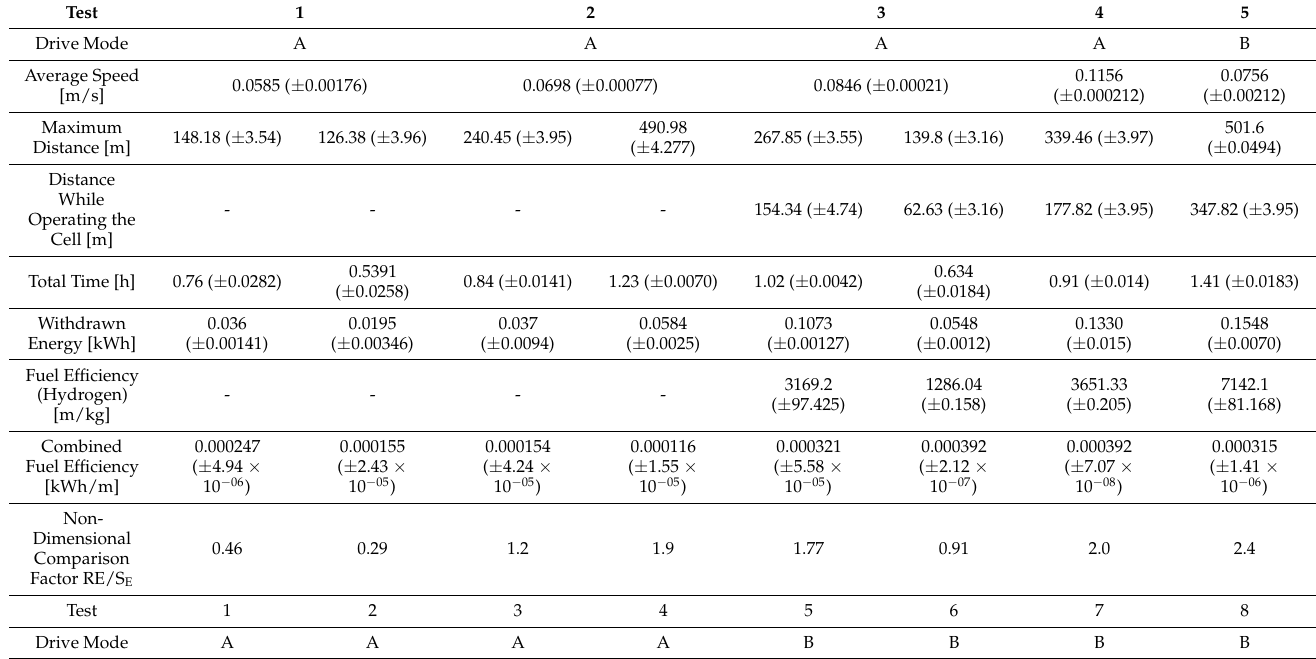
Table 3. Summary of results for the tests